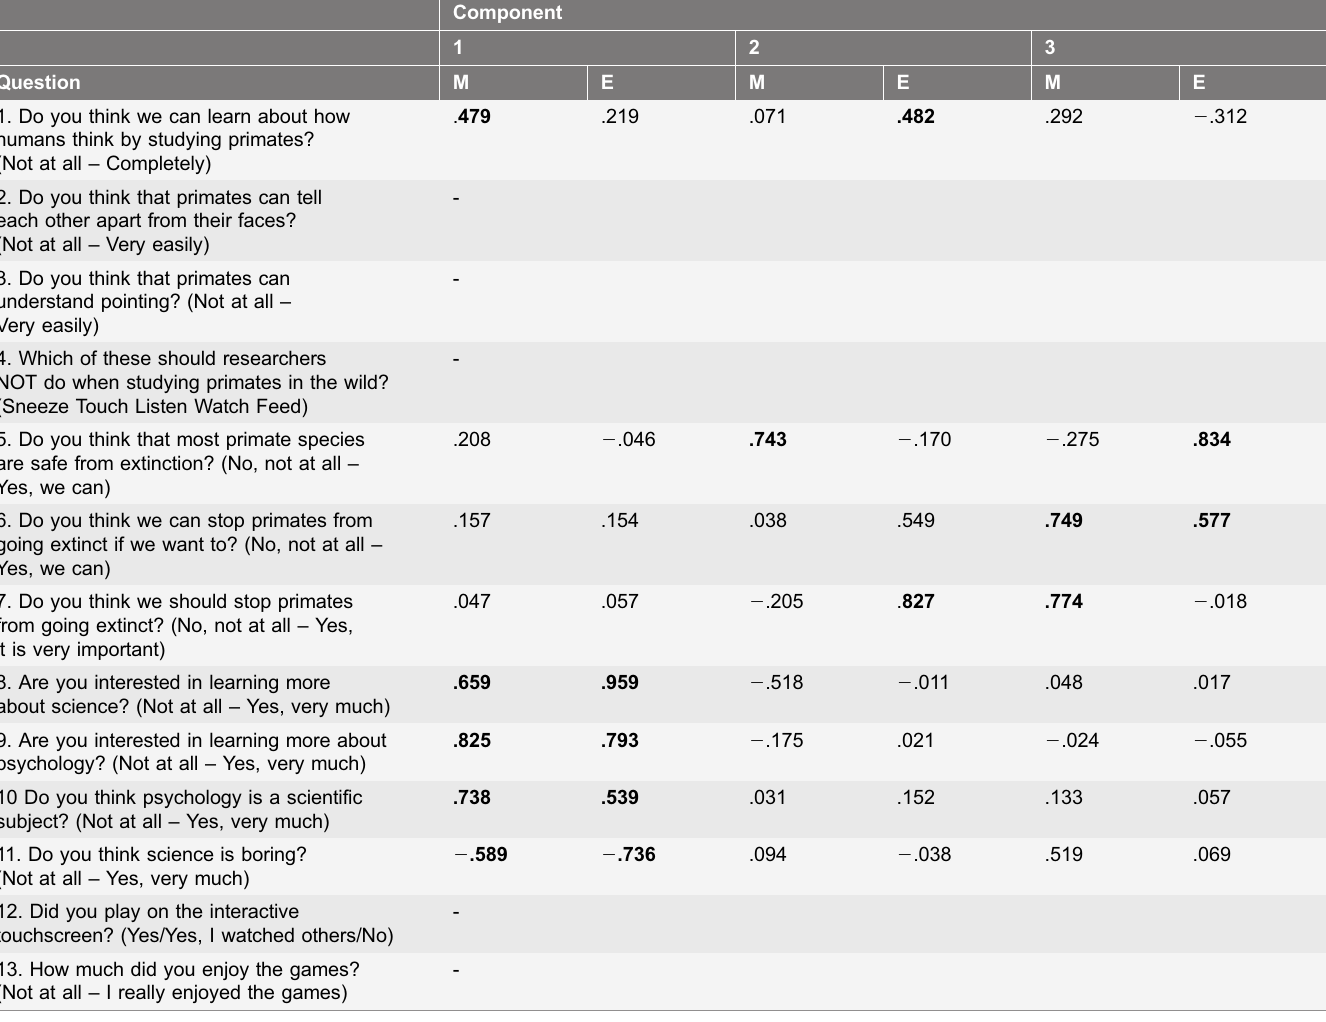
Table 1. Quesionaire questions and factor